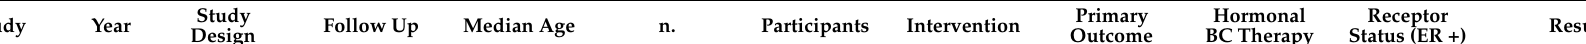
Table 3. Local hormonal